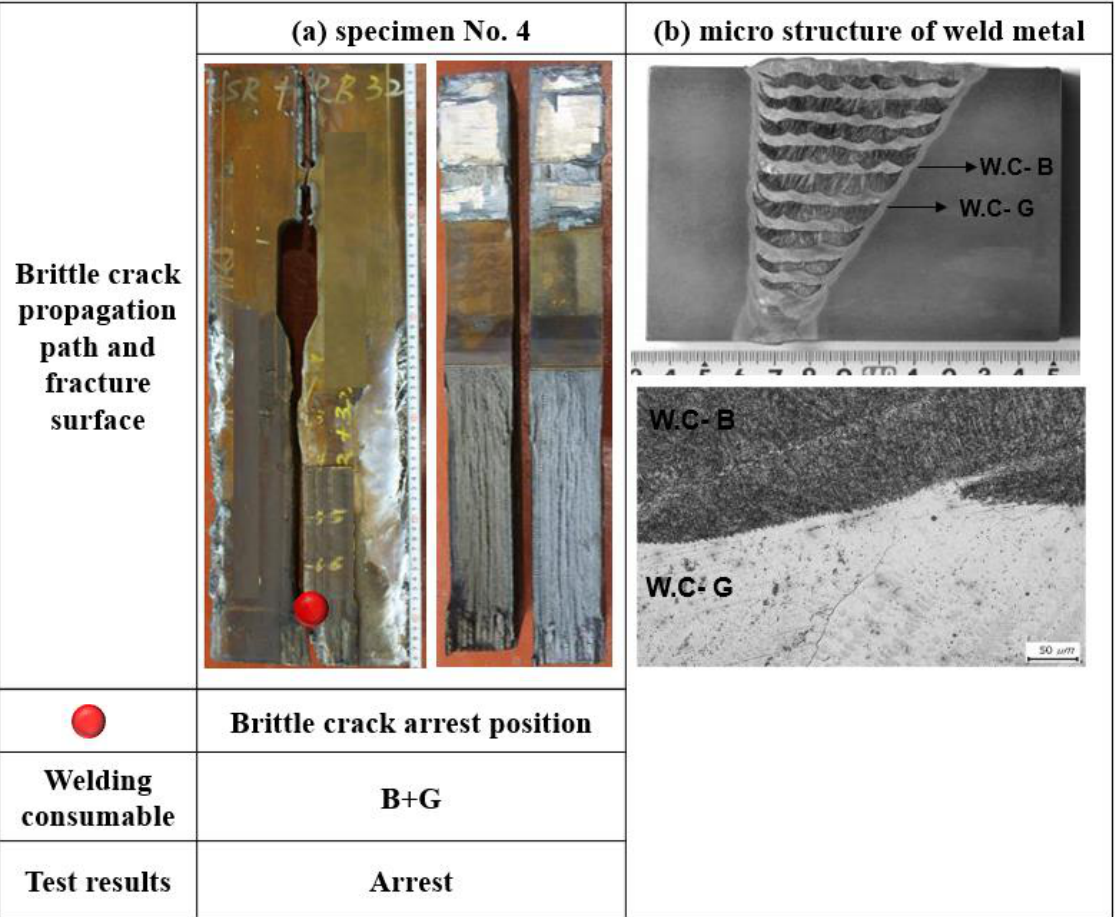
Figure 7. Brittle crack arrest position and the micro-structure of specimen-4. ( a ) Brittle crack arrest position and fracture surface; ( b ) macro structure and micro structure of weld metal B and